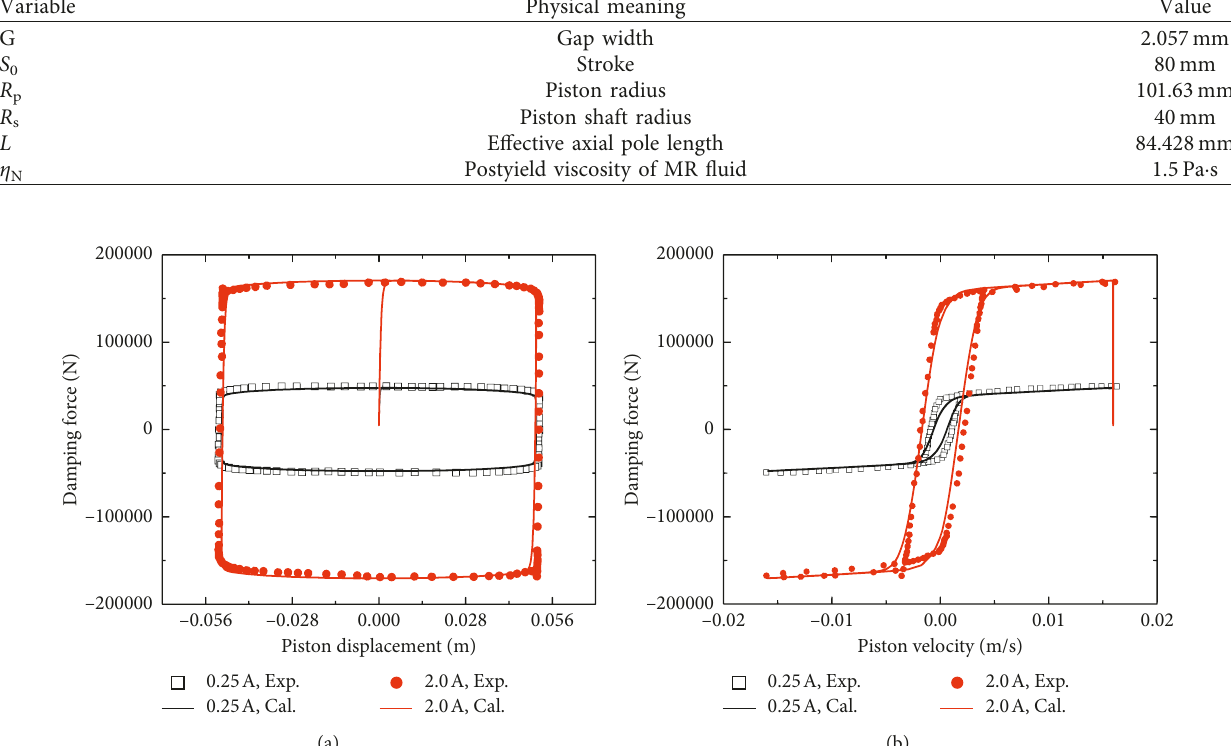
Figure 11: Model predictions (lines) and experimental data (Yang [34]) of hysteretic behavior of MR dampers under sinusoidal dis- placement excitations of 5.08cm, 0.05 Hz. (a) Displacement-force hysteresis. (b) Velocity-force hysteresis.